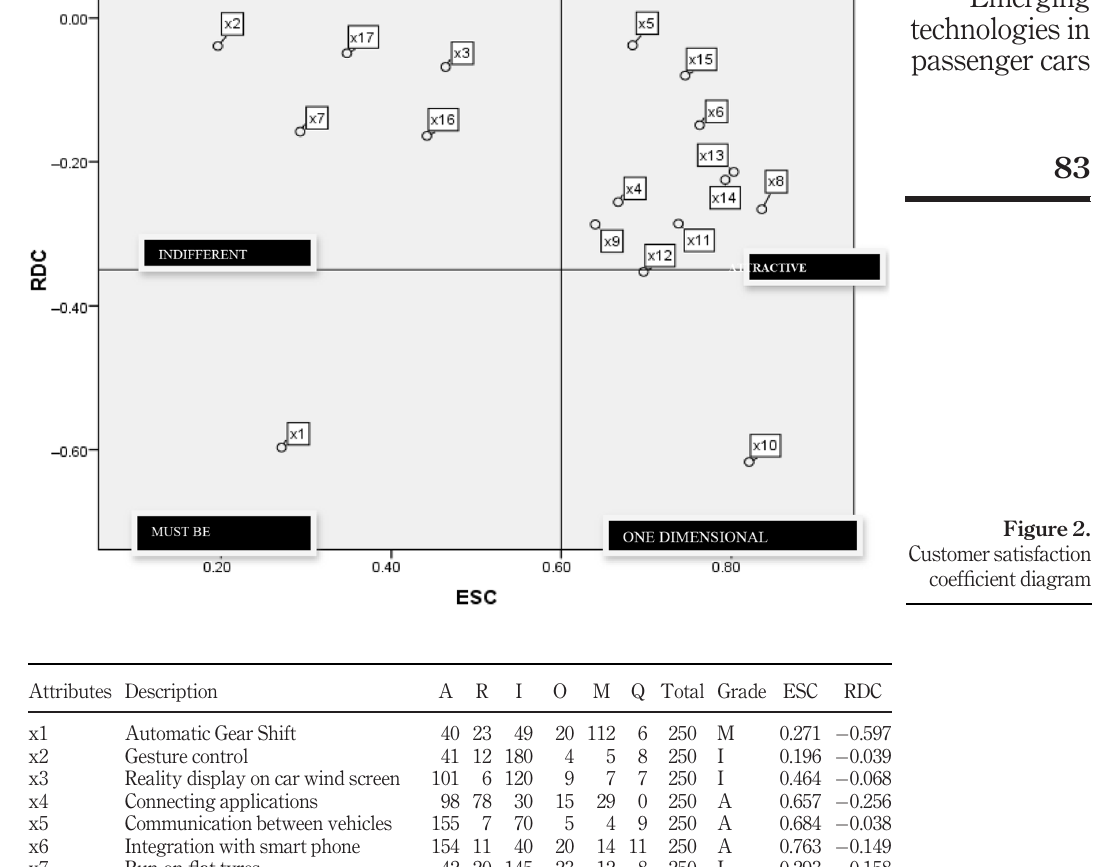
Table 4. Summary of